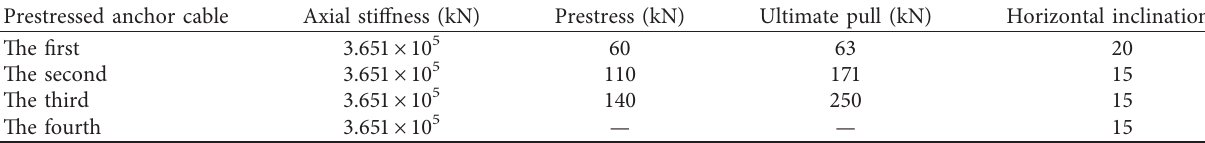
Table 4: Parameters of prestressed anchor cable.